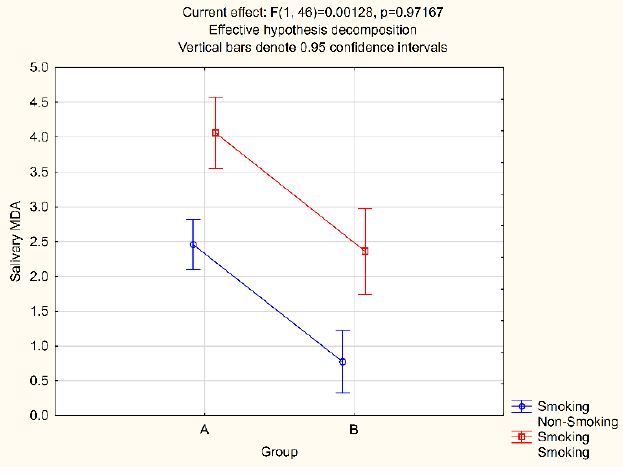
Figure 3. Salivary MDA and smoking interaction.